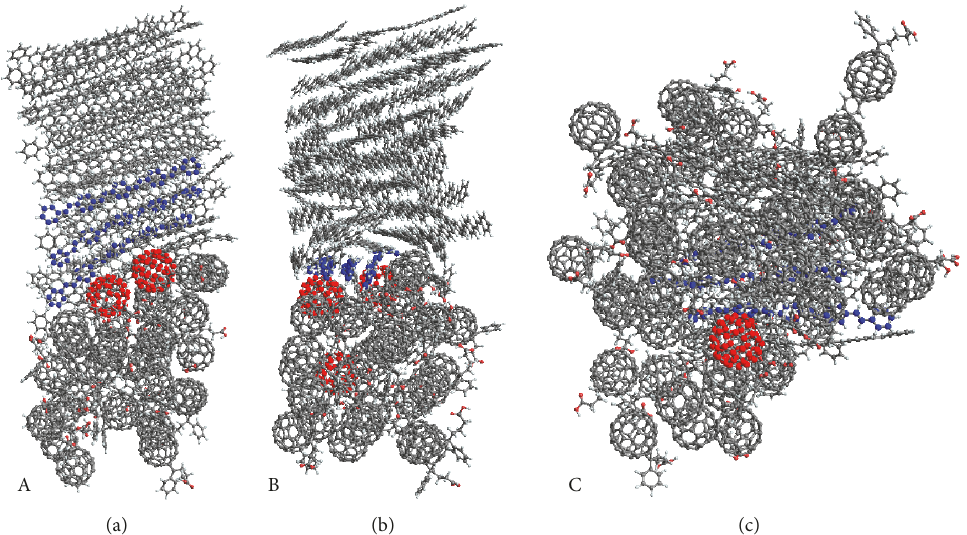
Figure 1: Snapshot of the three MD simulation cells: A, B, and C. The red and blue highlighted molecules denote the 𝜋 -active units in our